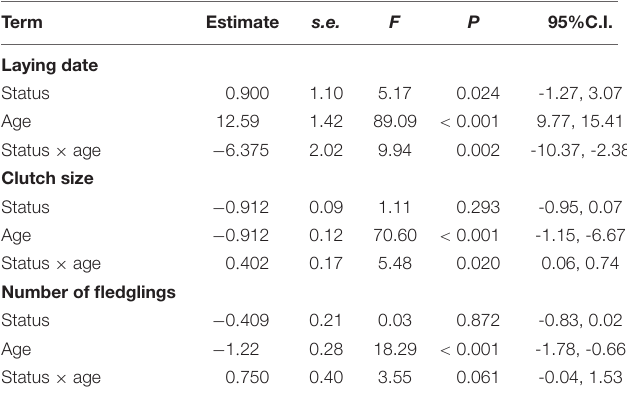
TABLE 4 | Results of LMMs for laying date, clutch size and number of fledglings produced by common kestrel females functions of dispersal status (immigrant vs. resident), age (young vs. adult) and the interaction between dispersal status and age.